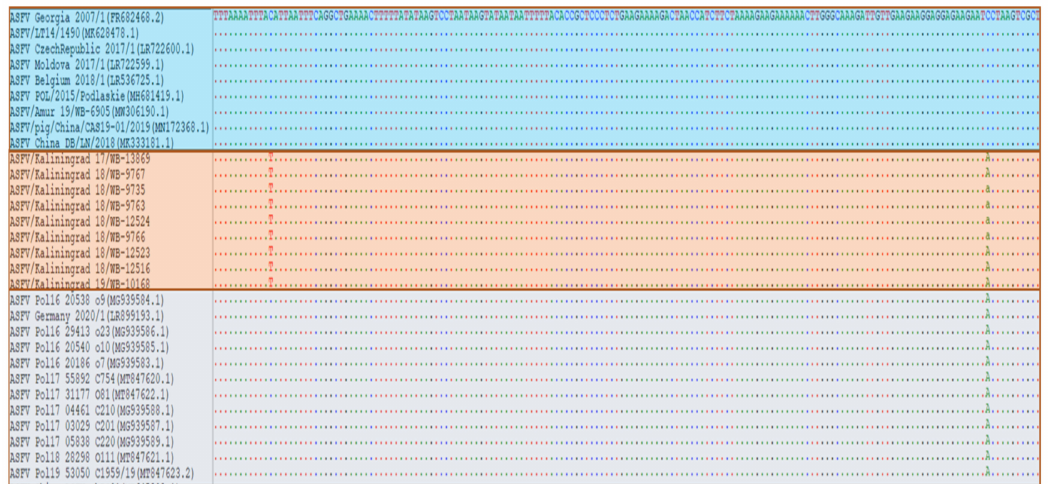
Figure 5. Nucleotide alignment of ASFV samples based on the partial sequence of the K145R gene and depicting only three groups. Blue color—group K145R-I , which is similar to Georgia 2007/1; gray color—group K145R-II isolates with one SNP (C-to-A transversion at position 434); orange color—group K145R-III isolates with two simultaneous SNPs (C > T at position 291 and C > A at position